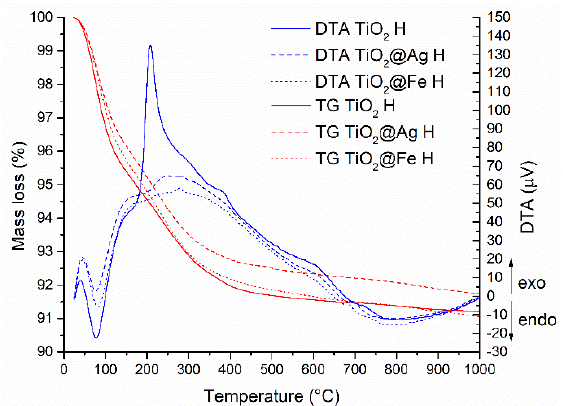
Figure 2. Thermal analysis (DTA and TG) corresponding to the samples obtained by the microwave- assisted hydrothermal (H) method.